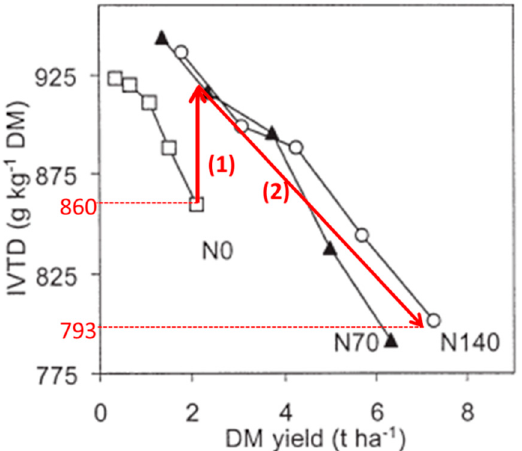
Figure 9. Changes in forage in vitro true digestibility (IVTD) of timothy with increasing forage mass (DM yield) in spring under three di ff erent N fertilizer application: N0, 0 kg N ha − 1 ; N70, 70 kg N ha − 1 ; N140, 140 kg N ha − 1 . Data obtained at Fredericton (45.55 ◦ N; 66.36 ◦ W; Canada) and redrawn from B é langer and McQueen [32]. Arrows express the two opposite e ff ects of the N supply on %D: (1) the increase in %D at similar herbage mass (W) as a consequence of an increase in Wm / W and (2) the decrease in %D as a consequence of the increased forage mass, and the “dilution” e ff